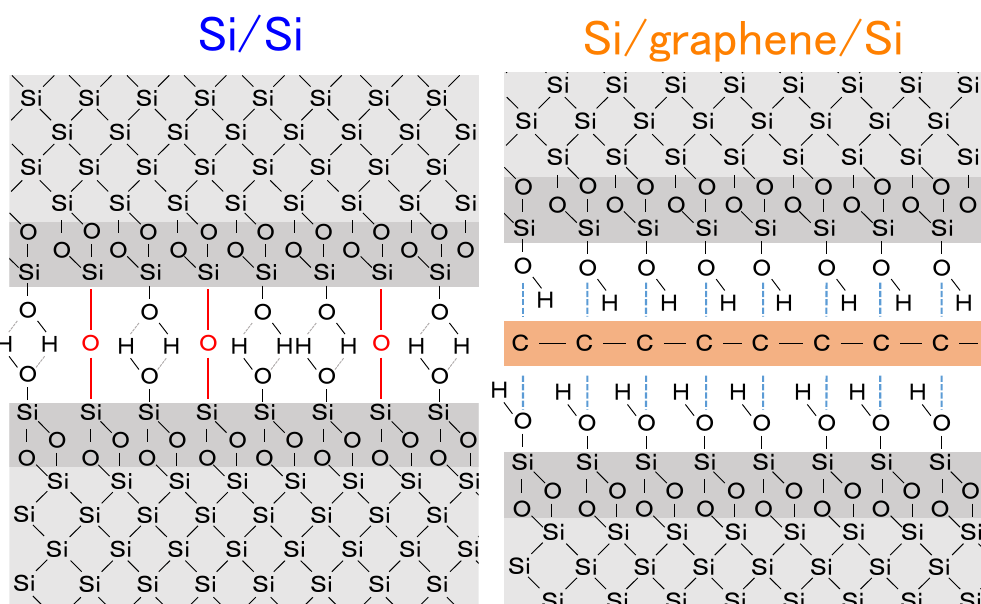
Figure 5. Conceptual schematic of a cross-sectional molecular view of the bonded interfaces: ( left ) Si/Si control structure, ( right ) Si/graphene/Si double heterostructure. Nanomaterials 2018 , 8 , x FOR PEER REVIEW